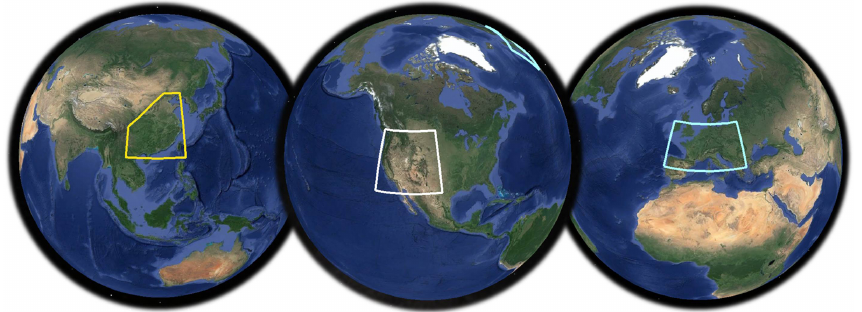
Figure 4. Regions of interest: eastern Asia (corner points: 41.5 ◦ N, 116 ◦ E; 30 ◦ N, 102.5 ◦ E; 20 ◦ N, 102.5 ◦ E; 20 ◦ N, 123 ◦ E; 41.5 ◦ N, 116 ◦ E), the western US (box between 30 and 50 ◦ N, 125 and 100 ◦ W), and Europe (box between 40 and 55 ◦ N, 10 ◦ W and 25 ◦ E).